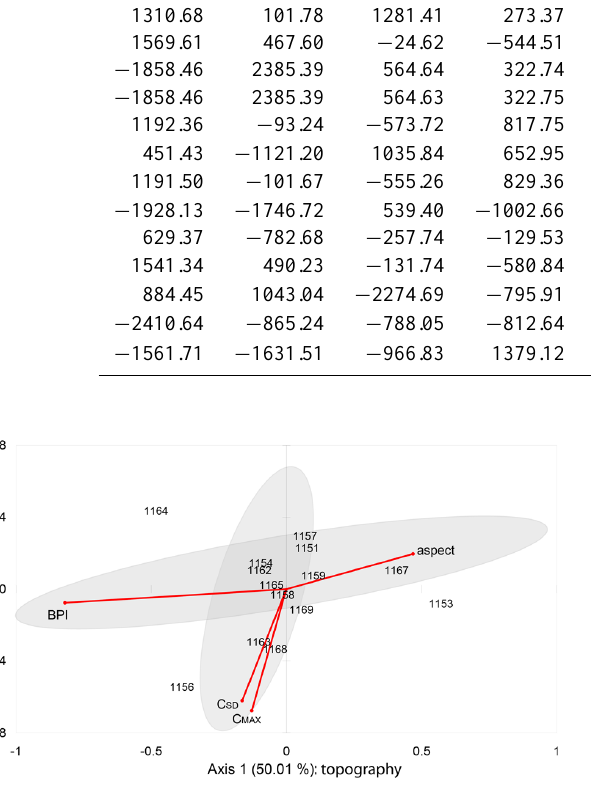
Fig. 3. Environmental control of assembly at broad (across reef) spatial scales determined by topographic variation in BPI and as- pect (near horizontal shaded ellipse) and hydrographic variability in C MAX and C SD (near vertical shaded ellipse). Line length reflects the strength of a variable with respect to community assembly. Sites are also indicated to demonstrate the wide range of environmental settings that control species and functional assembly of reef com- munities.